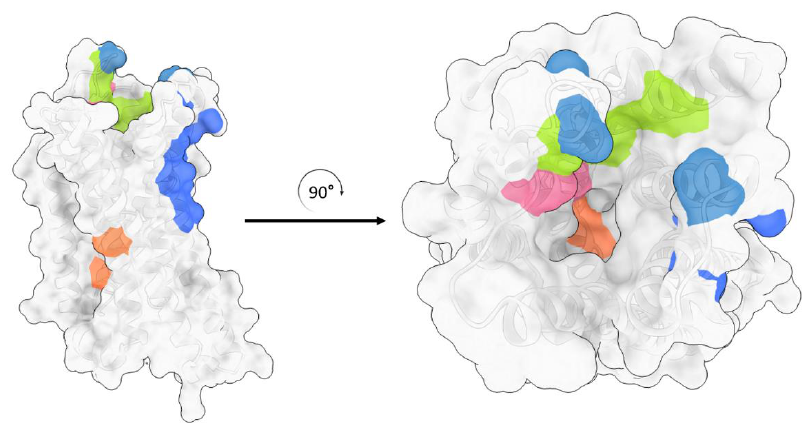
Figure 6. The in silico prediction of potential allosteric binding sites for PAMs and NAMs including cholesterol, small molecules, and ions. Each color depicts a potential site, and five sites are illustrated [61,80,94,97,98].